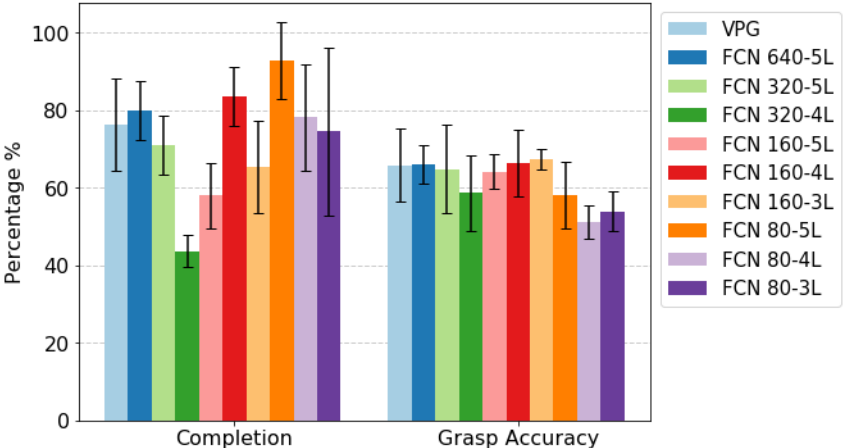
Figure 8. Comparison over testing scenarios between the proposed architectures. Error bars represent the standard deviation over five distinct runs of the testing